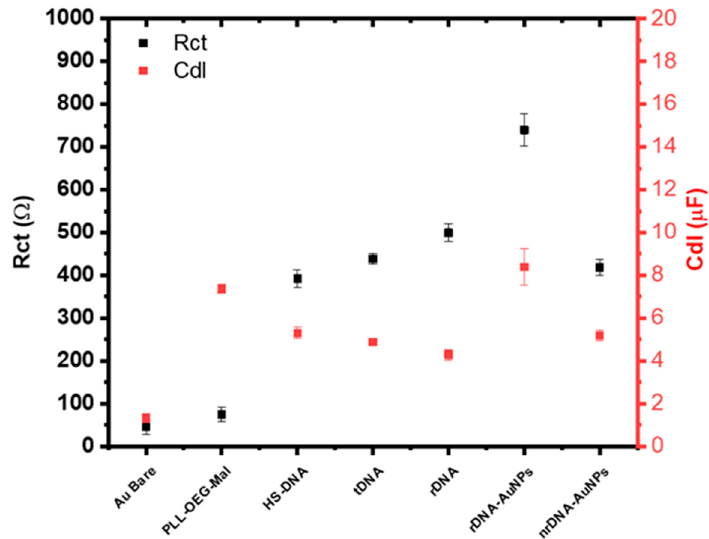
Figure 4. The charge transfer resistance ( R ct ) and double-layer capacitance ( C dl ) obtained by fitting the EIS data (Figure 3) to a Randles equivalent circuit (shown in the inset of Figure 3a) for each functionalization step. Standard deviations (see also Table S2) are based on three individual measurements performed on different samples, for each functionalized substrate.